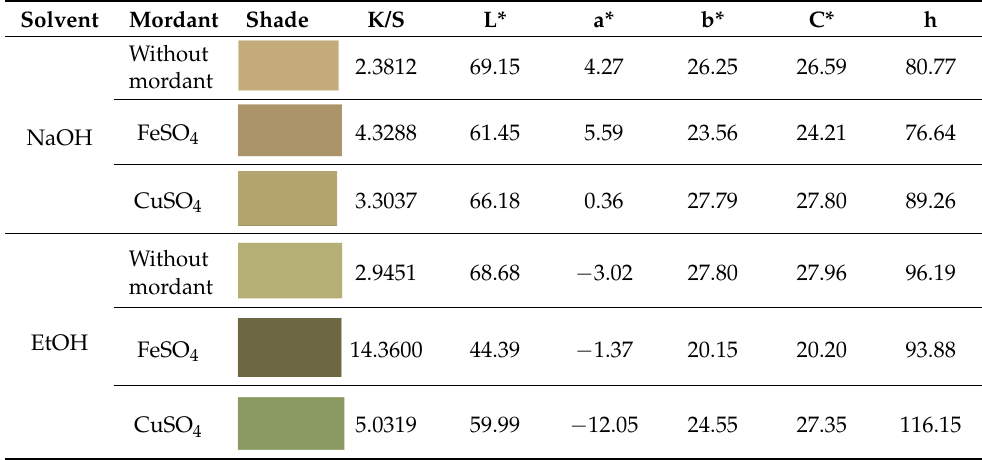
Table 7. Color properties of dyed cationized cotton fabric with and without